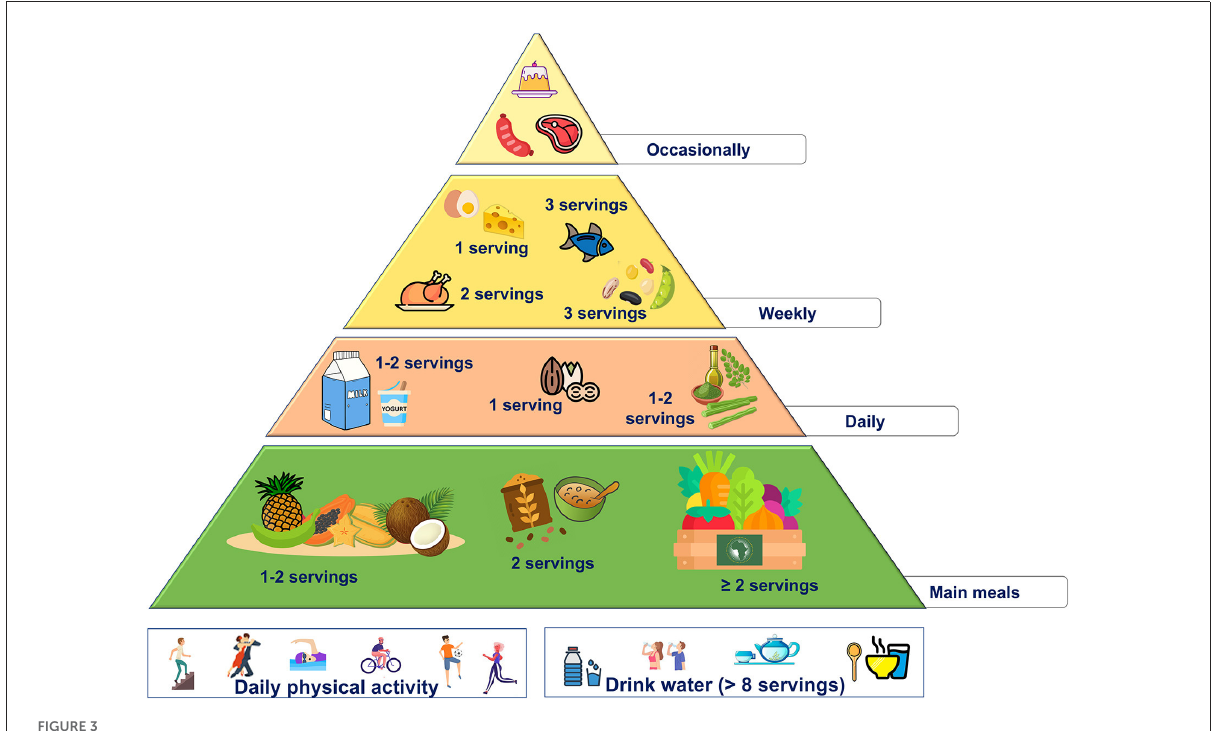
FIGURE3 Proposed nutritional pyramid for